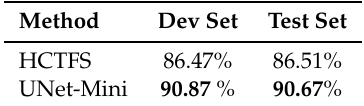
Table 1. Comparison of classification recognition rates. Bold font indicates best results.